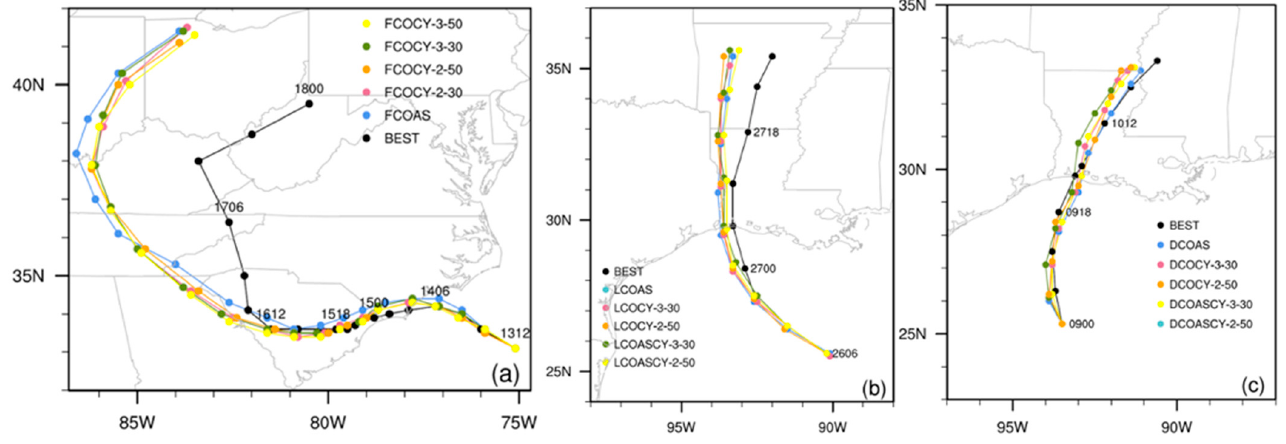
Figure 9. Same as Figure 6. Forecast track of all assimilation experiments against the NHC best-track data (BEST) for ( a ) Florence (1200 UTC 13 to 0000 UTC on 18 September 2018), ( b ) Laura (0600 UTC 26 to 0600 UTC on 28 August 2020), and ( c ) Delta (0000 UTC 09 to 0000 UTC on 11 October 2020).